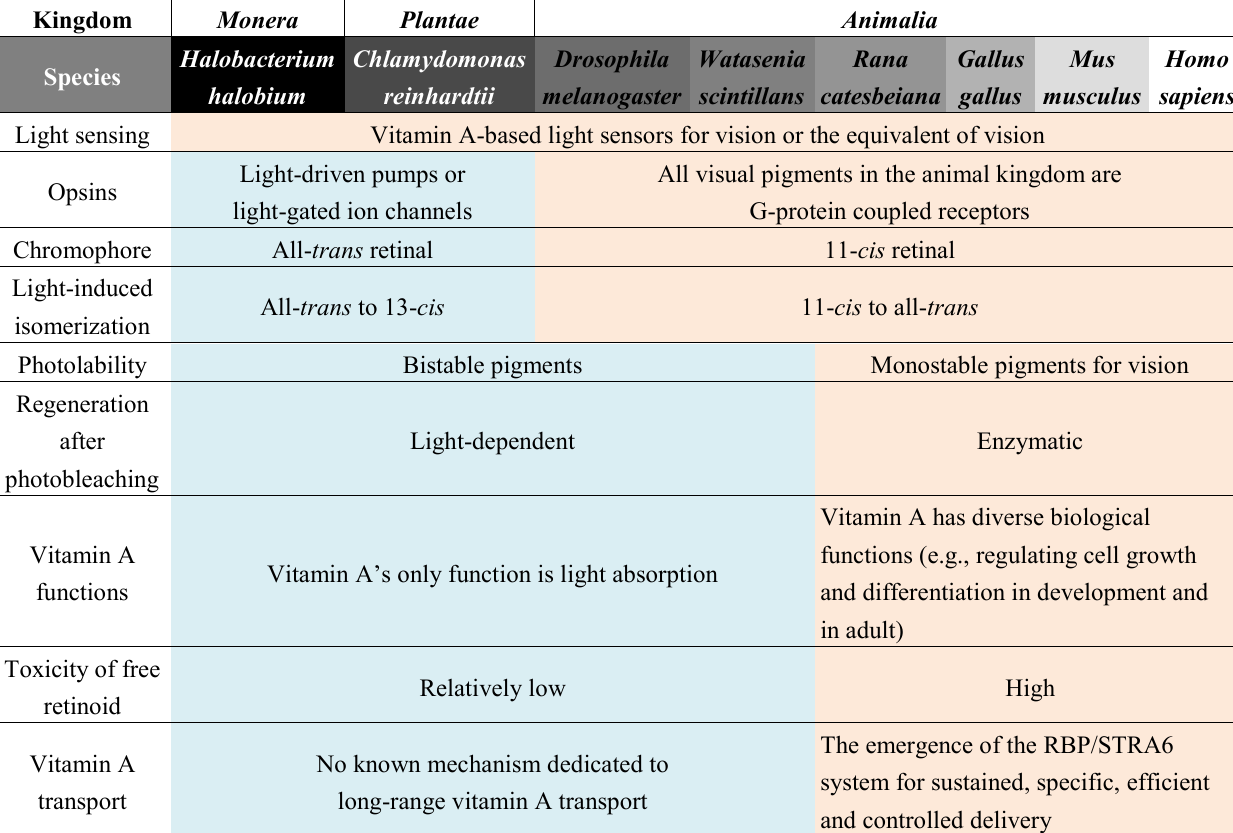
Table 2. Convergent and divergent events in the evolution of vitamin A-based light